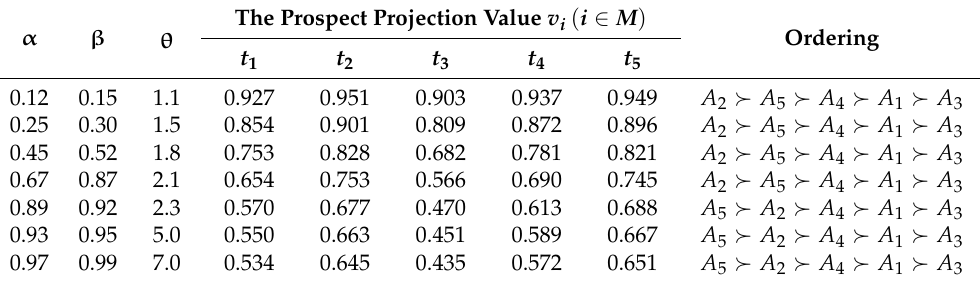
Table 2. Sensitivity analysis of the optimal alternatives with respect to parameters α , β , and θ